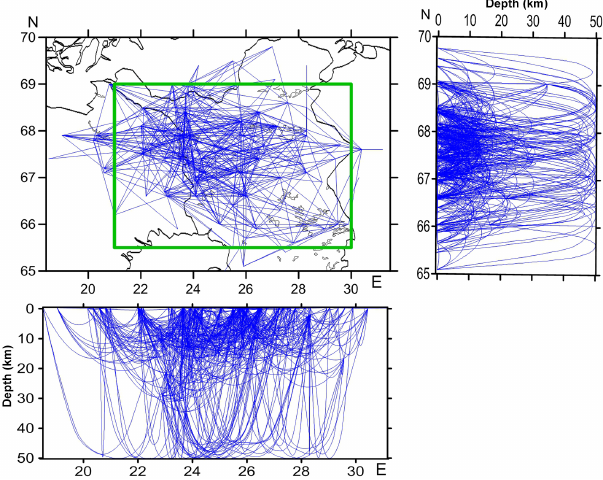
Figure 7. The ray coverage of the area in the horizontal and two vertical